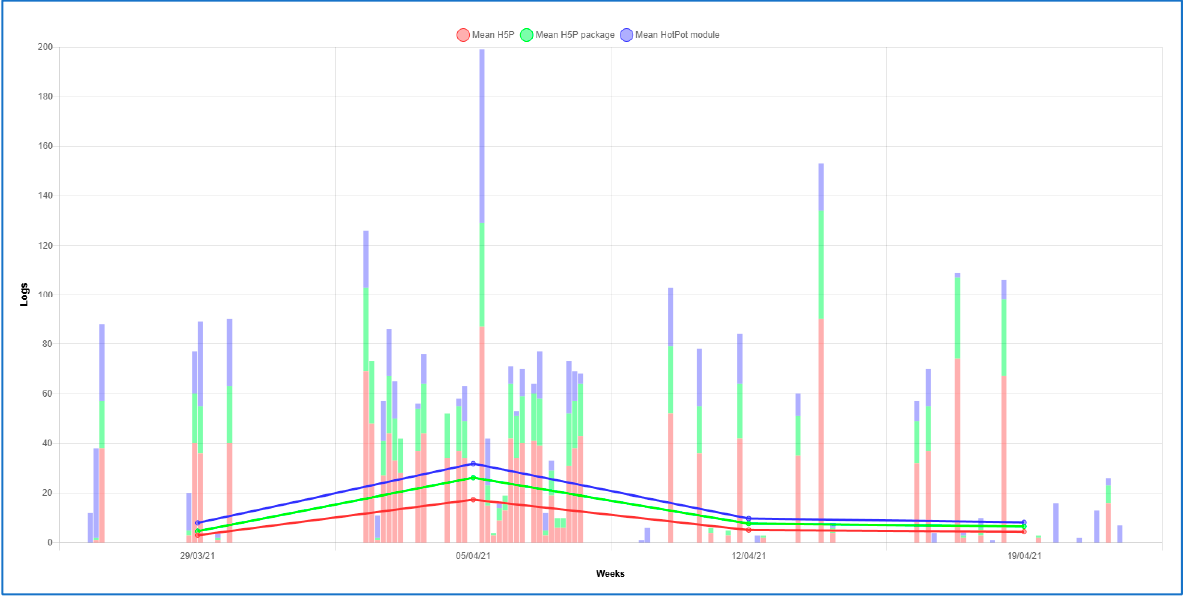
Figure 2. Stacked bar of the interaction records of the occupational therapy students in the DGBL activities.